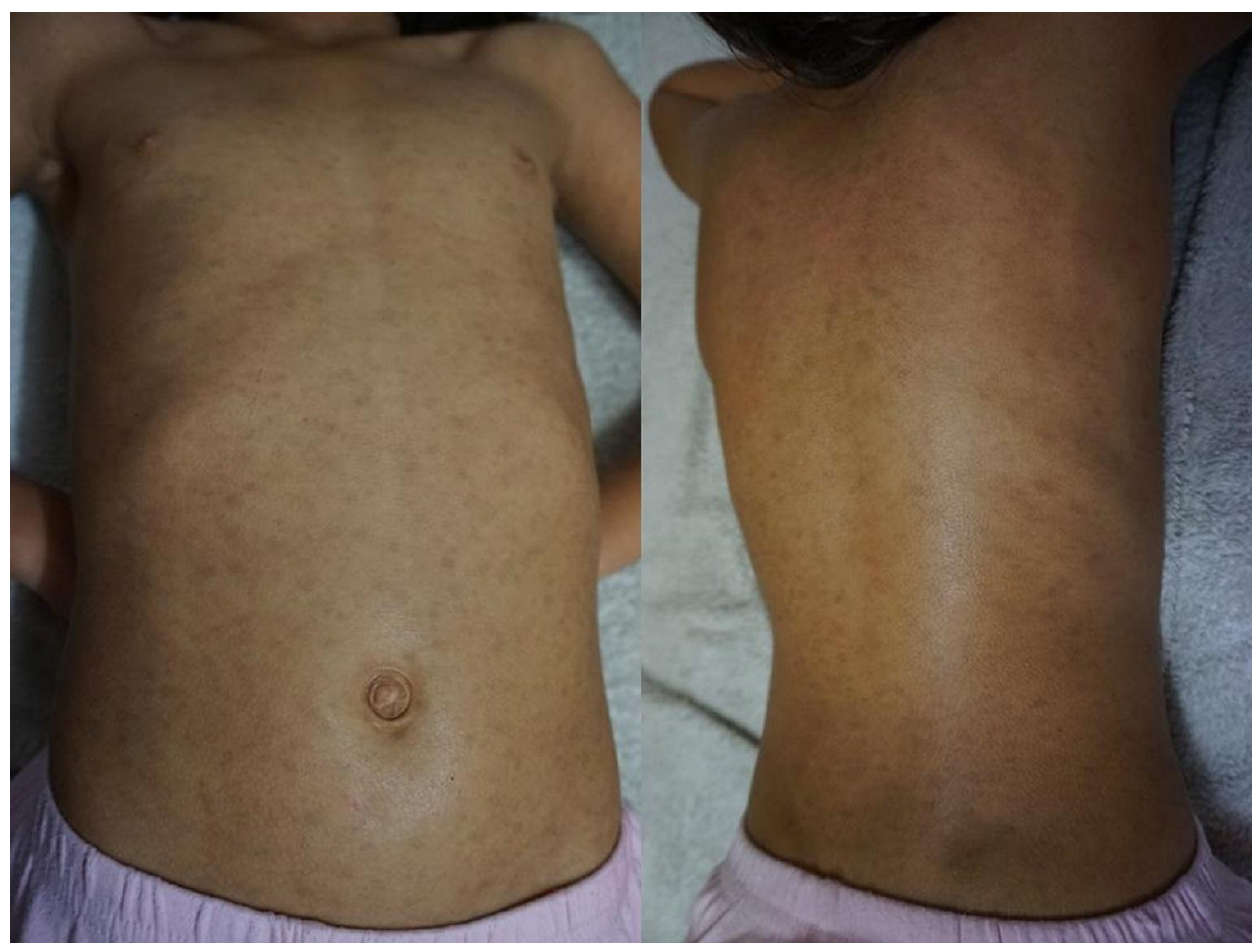
Figure 1 : Multiple discrete, dark-brown, round-to-oval, small (< 1 cm in diameter), well-defined, nonconfluent macules over the front and back of the patient´s